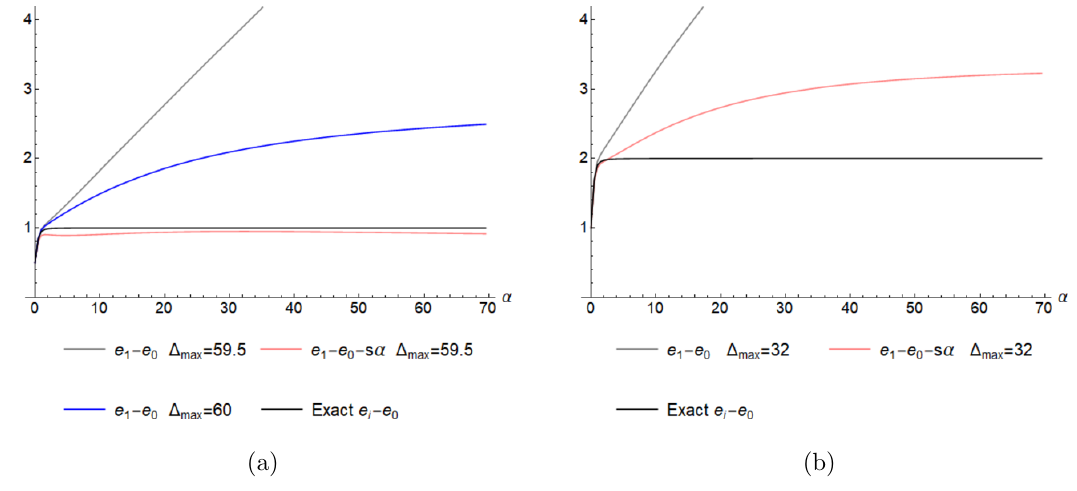
Figure 3. (a) e 1 (cid:0) e 0 (cid:0) s(cid:11) vs (cid:11) > 0 with s given by the interaction matrix eigenvalues for the free spectator for (cid:1) max = 59 : 5 and (cid:1) max = 60; (b) e 1 (cid:0) e 0 (cid:0) s(cid:11) vs (cid:11) > 0 with s given by the interaction matrix eigenvalues for the (cid:12)xed spectator with (cid:1) max =